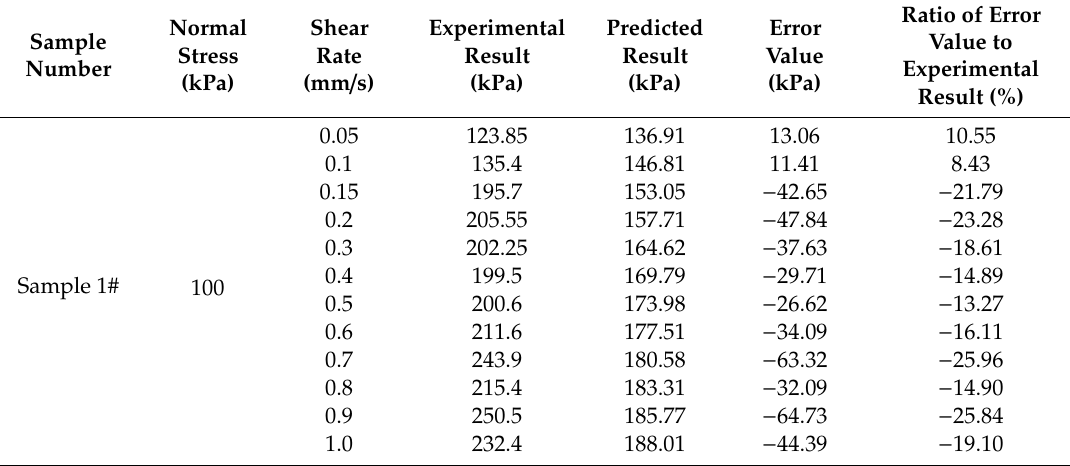
Table A6. Theoretically predicted results of peak shear strength for granite discontinuity samples calculated via the new empirical equation and the corresponding error